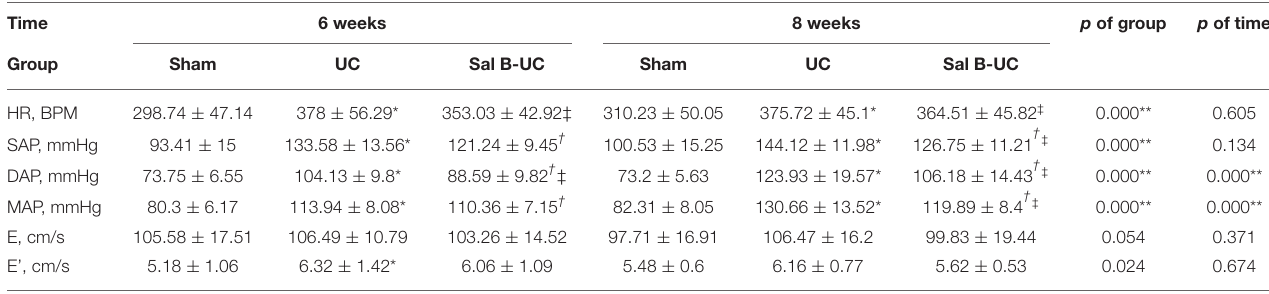
TABLE 2 | Blood pressure and Doppler hemodynamic measurements in rats at 6 and 8 weeks. Time